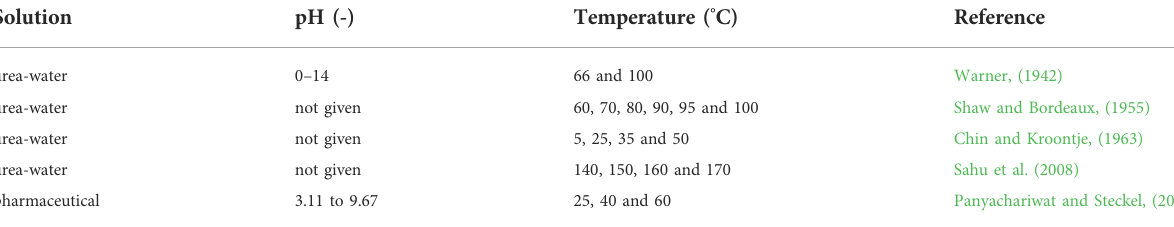
TABLE 1 pH and temperature conditions for various urea